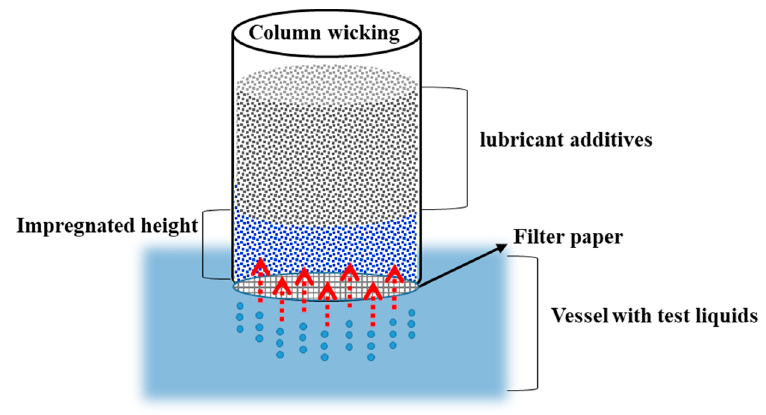
Figure 2. Schematic diagram showing column wicking of lubricant.